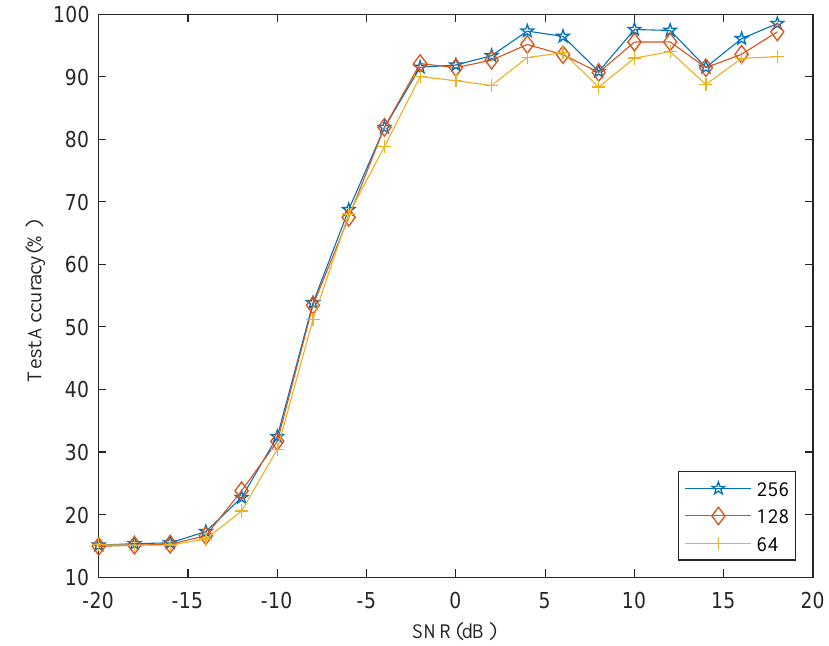
Figure 12. Recognition accuracy of different number of convolution